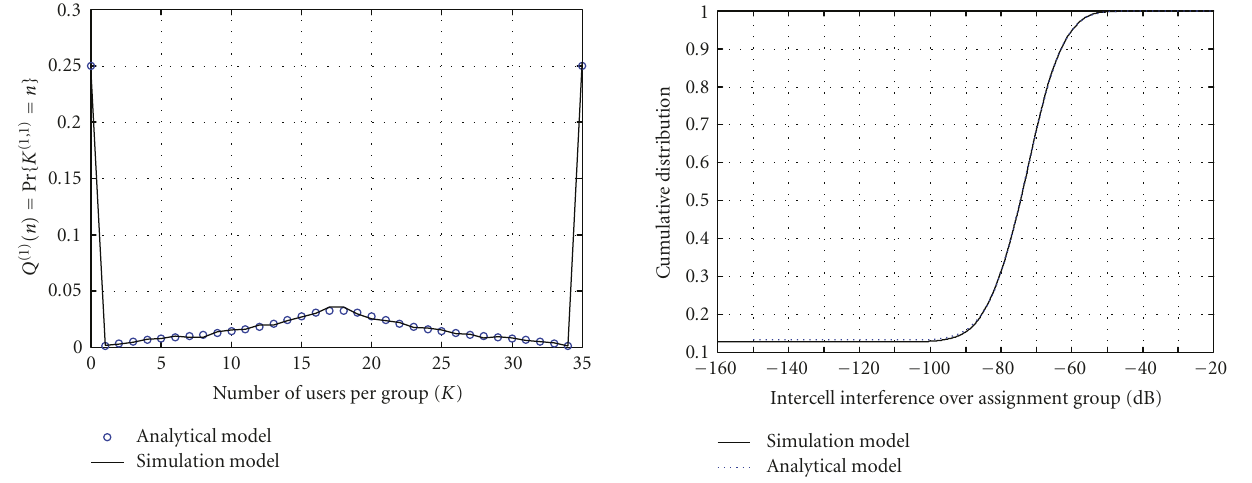
Figure 3: Cumulative distribution of intercell interference on as- signment group in a 3-cell